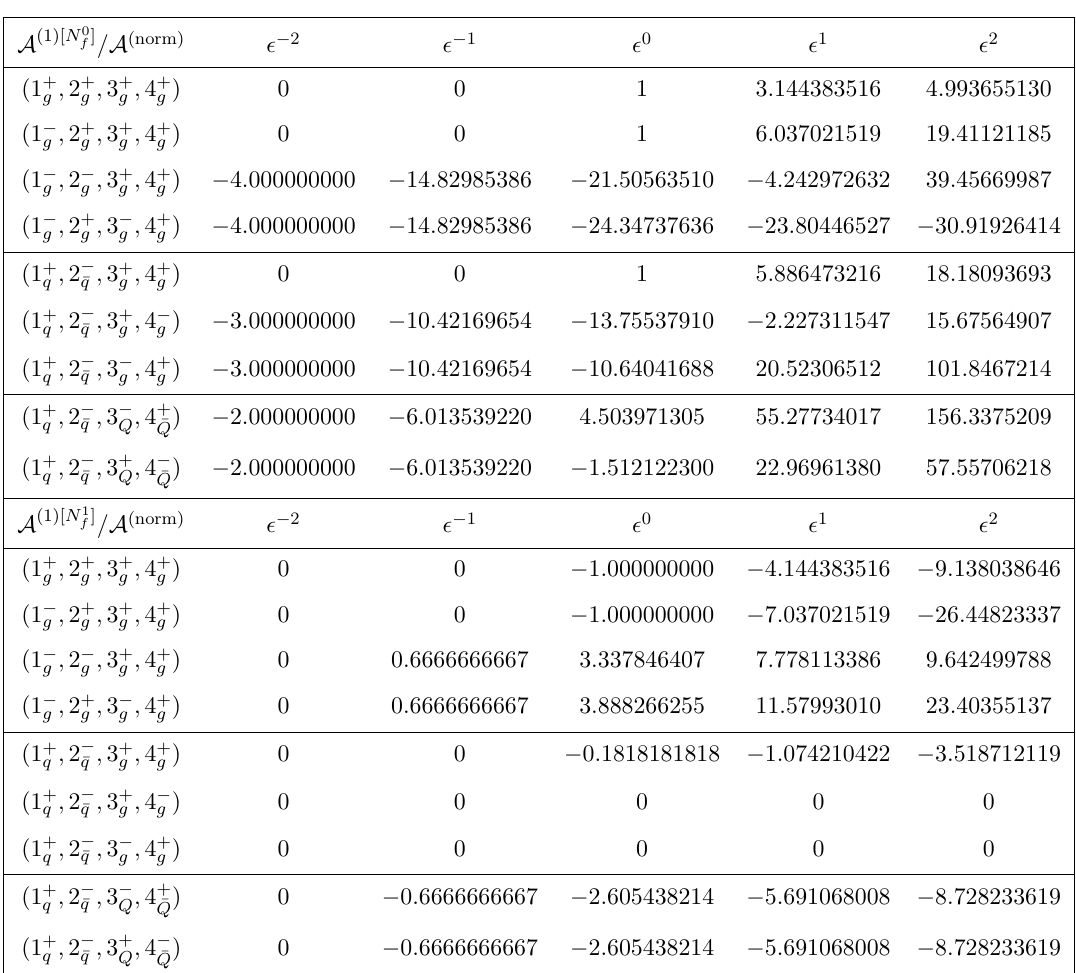
Table 3 . The bare one-loop four-parton helicity amplitudes evaluated at the phase space point in eq. (4.1). We set the normalization factor A (norm) to A (1)[ N 0 f ] ( (cid:15) = 0) for the amplitudes with vanishing trees, and to A (0)